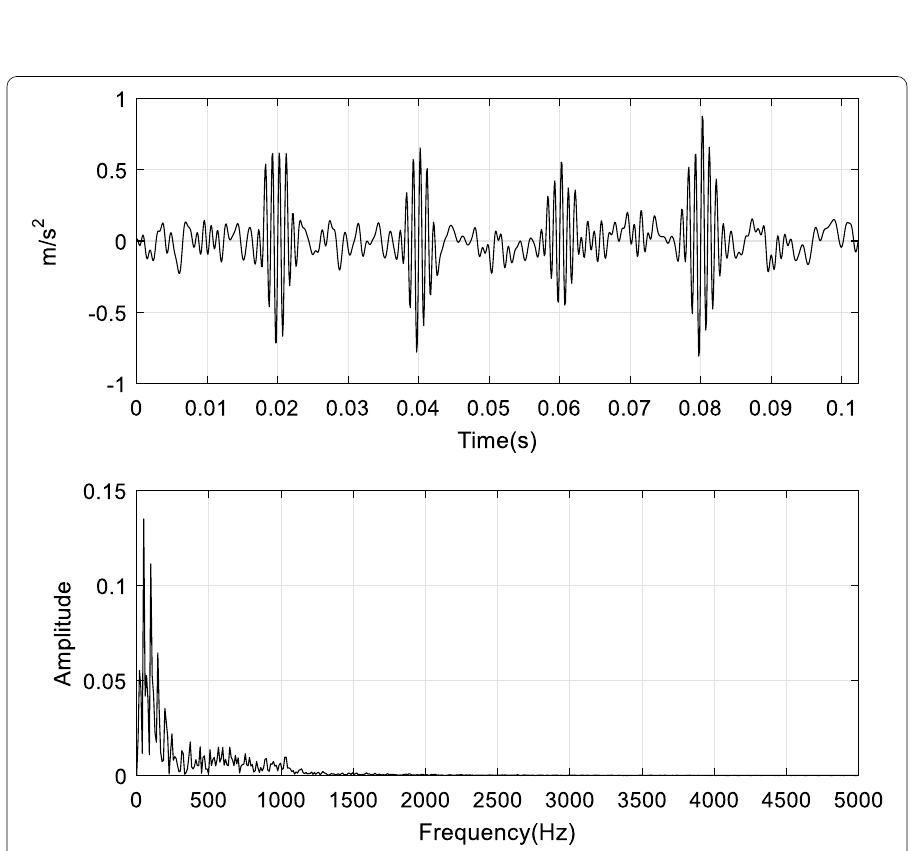
Fig. 6 Waveform and envelope spectrum of characteristic sub-band signal extracted by adaptive